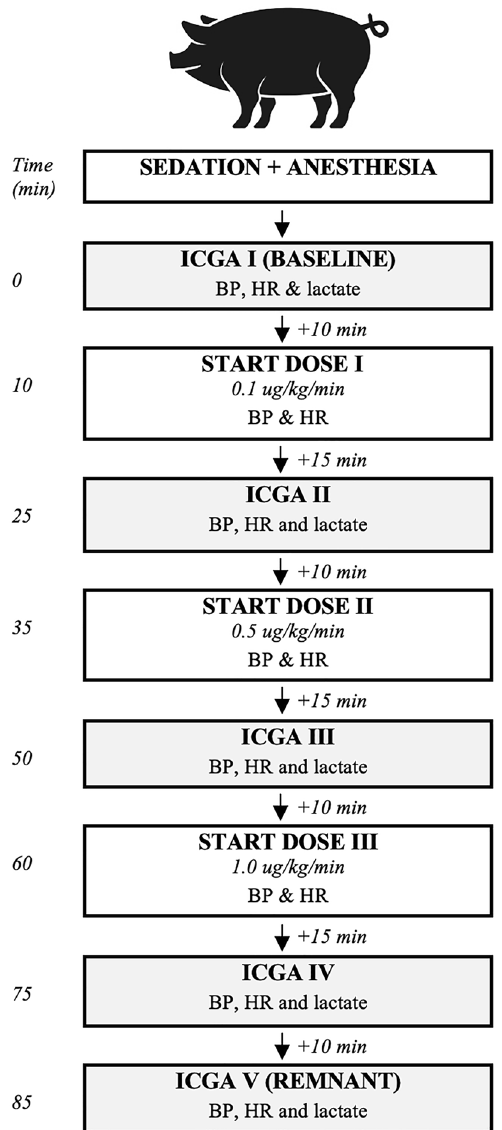
Figure 2. Study flowchart. ICGA indocyanine green angiography, BP blood pressure, HR heart